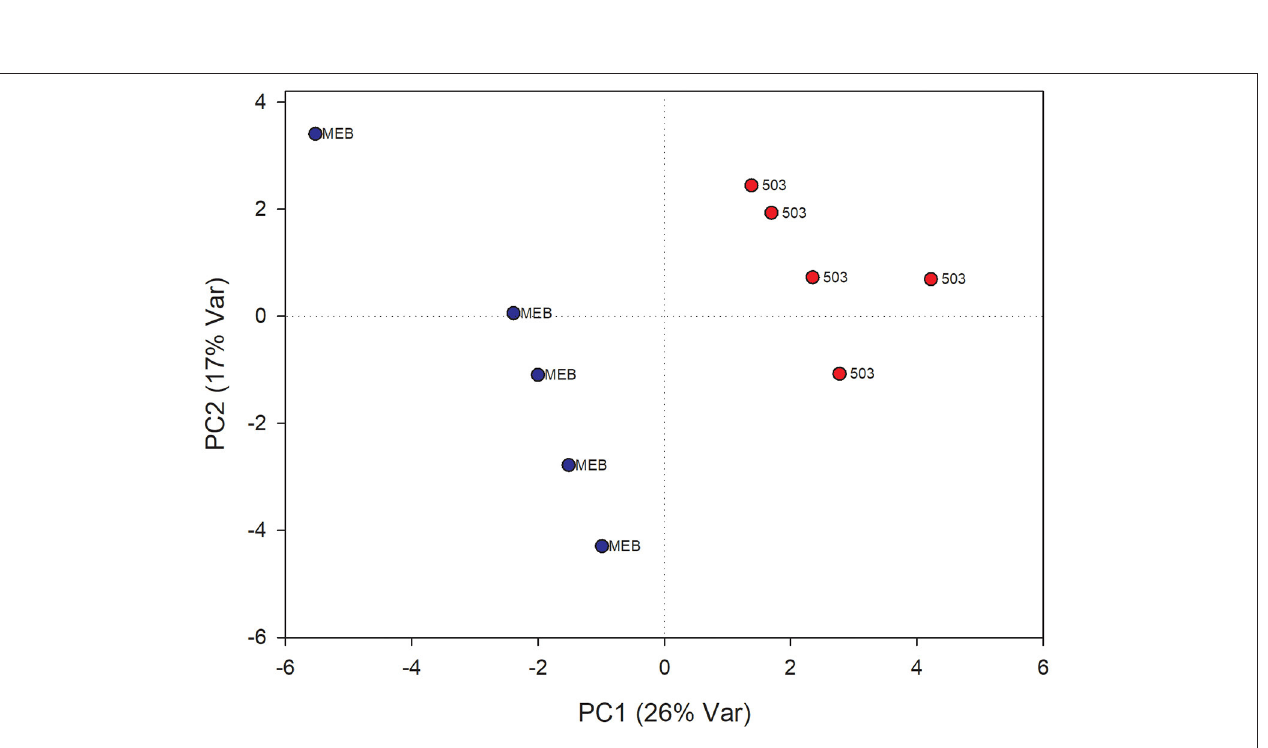
Frontiers in Plant Science |